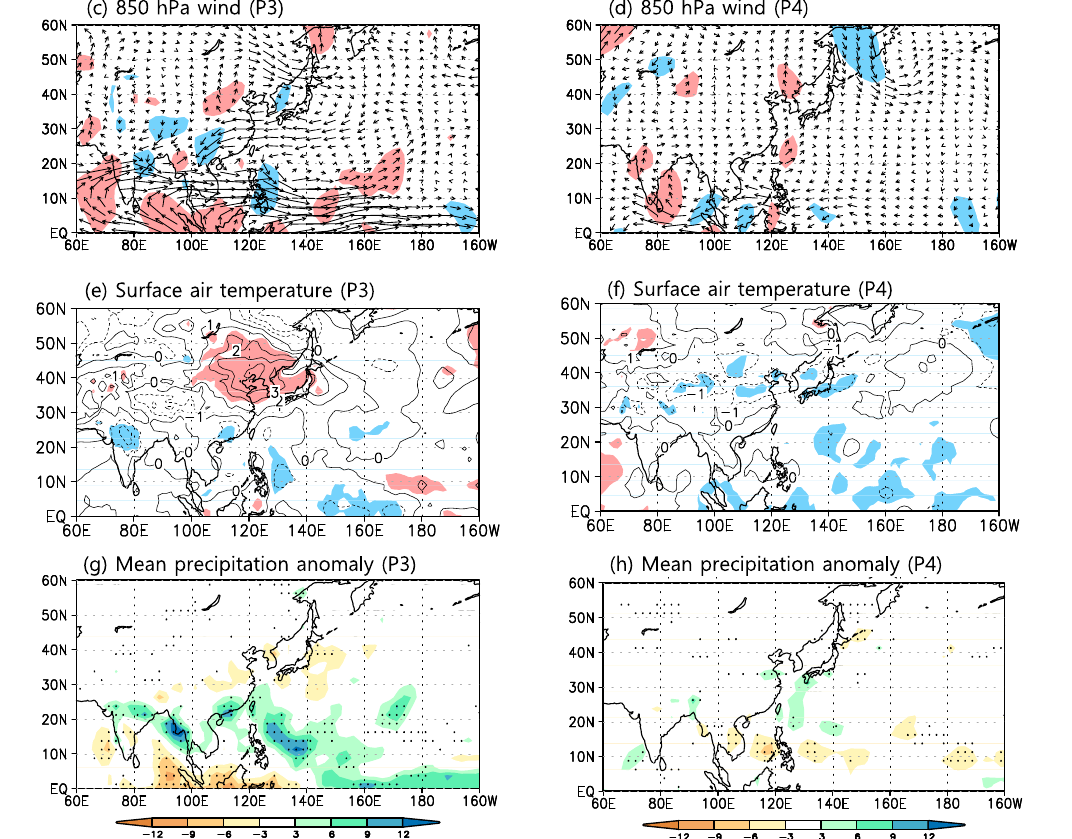
Figure 5. Composite differences of the high pass filtered summertime 500 hPa height (( a , b ), Unit: gpm), 850 hPa wind (( c , d ), Unit: m/s), surface air temperature (( e , f ), Unit: ◦ C) and precipitation (( g , h) , Unit: mm/day) anomalies between the summer high- and low-IODI during the periods P3 and P4. In the height, wind, surface air temperature field, the shaded areas denote the significance at the 90% confidence level with the Student’s t -test in each period length. In the precipitation field, the shaded areas indicate value and dotted areas denote the significance at the 90% confidence level with the Student’s t -test in each period length.